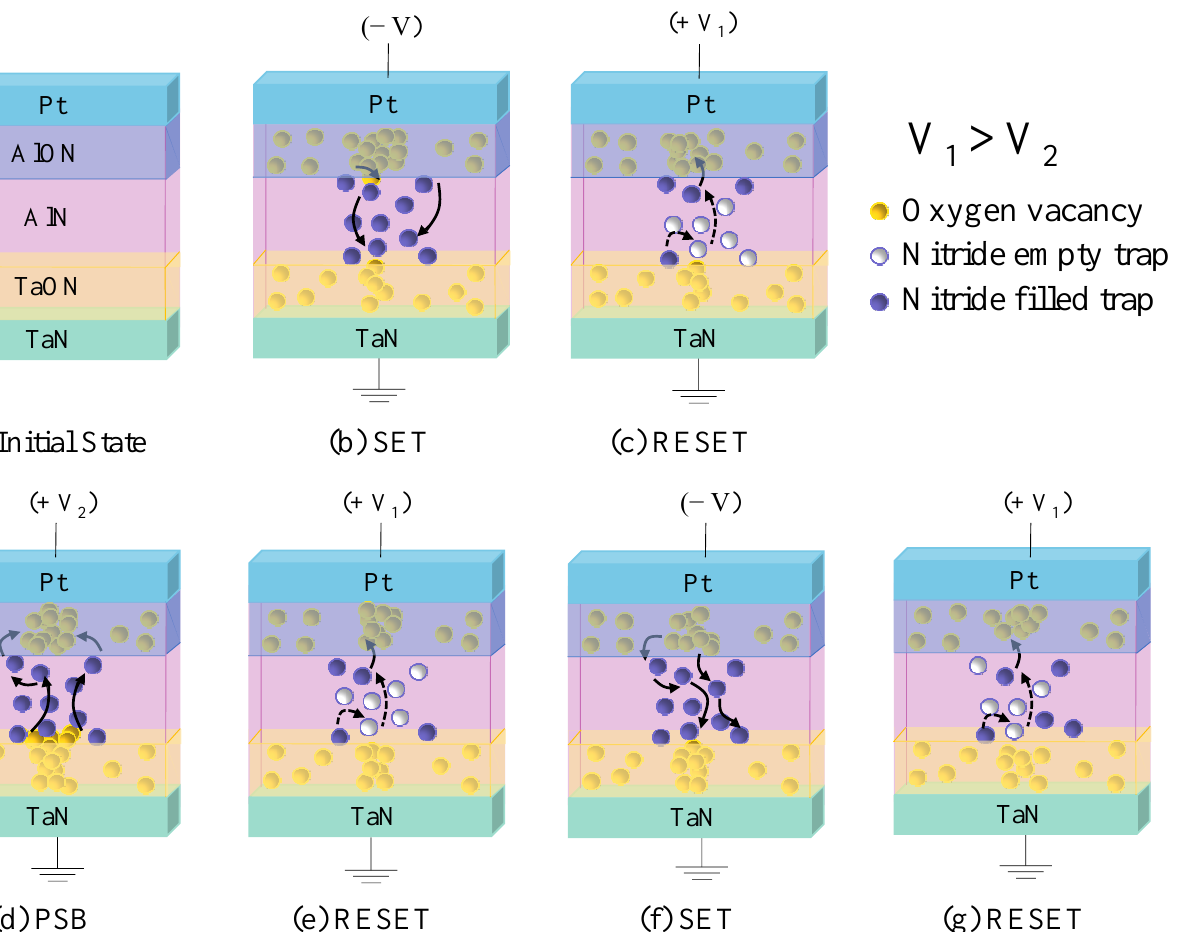
Figure 4. Schematics of switching process: ( a ) initial state, ( b ) set, and ( c ) reset process. Schematics of switching process after positive soft breakdown: ( d ) PSB, ( e ) first reset after PSB, ( f ) set, and ( g ) reset process.